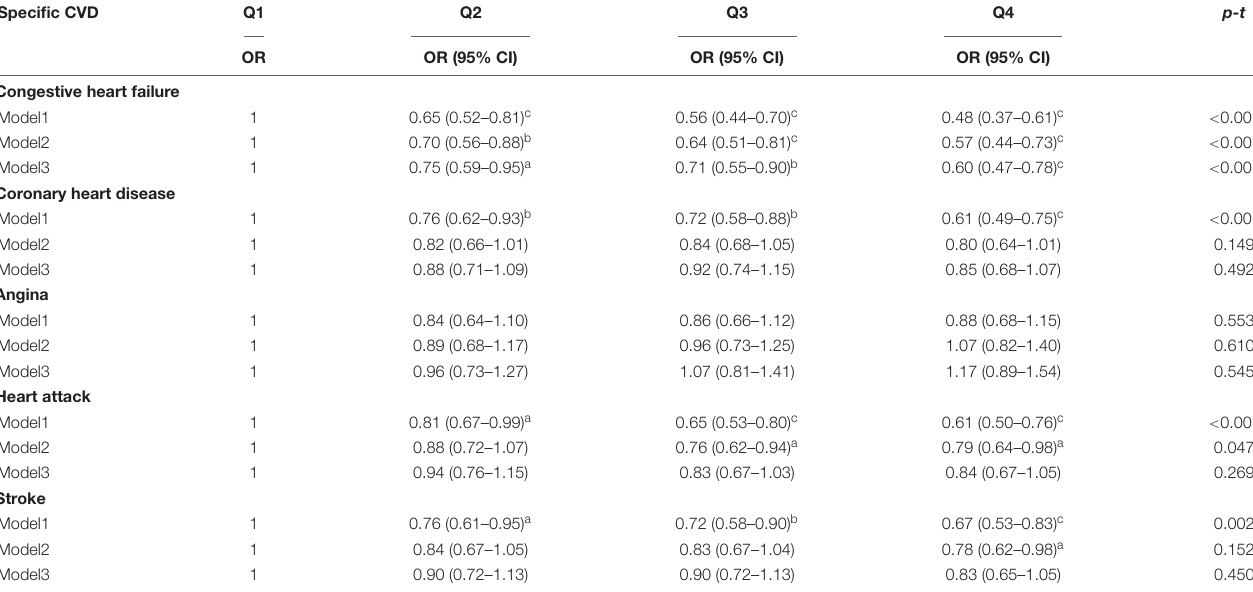
TABLE 3 | Logistic regression results for relationship between Klotho and specific cardiovascular disease